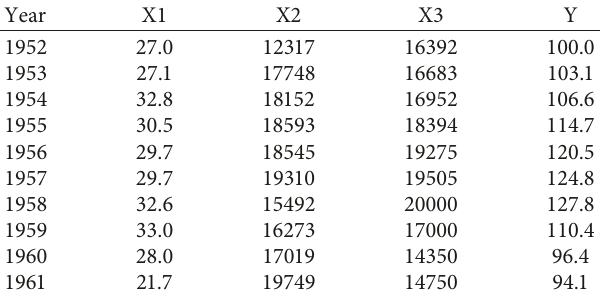
Table 3: China’s total agricultural output value and factors from 1952 to 1961.